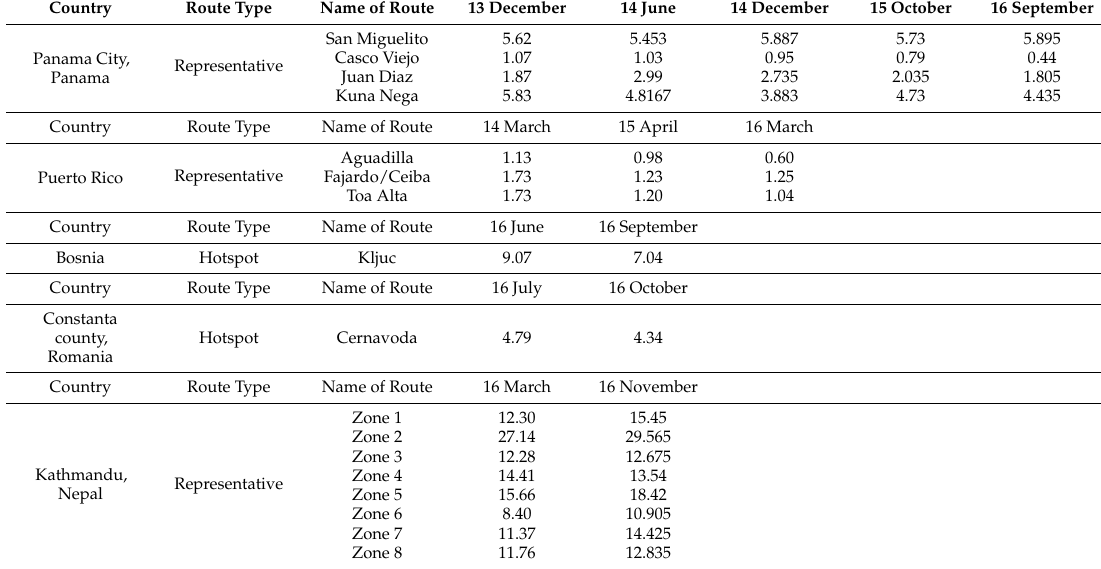
Table 2. Monitoring data resulting from repeat surveying along standard routes in five locations.